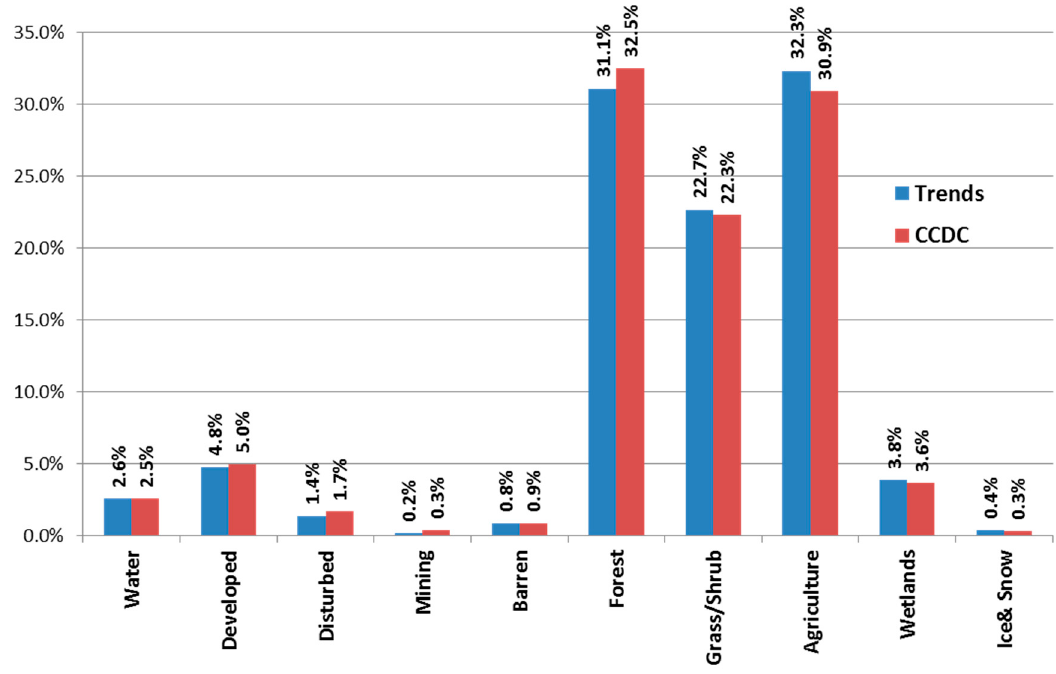
Figure 3. Class distribution for CCDC and LC Trends output over the total area of comparison.